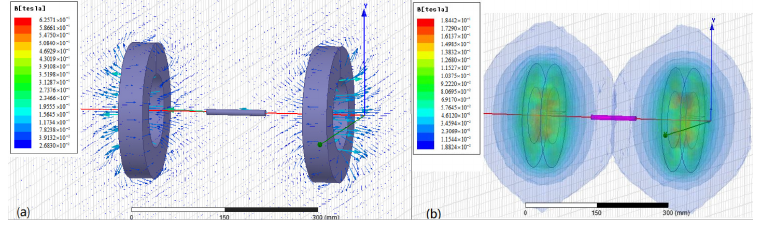
Figure 5. ( a ) Magnetic field intensity vector diagram. ( b ) Magnetic induction